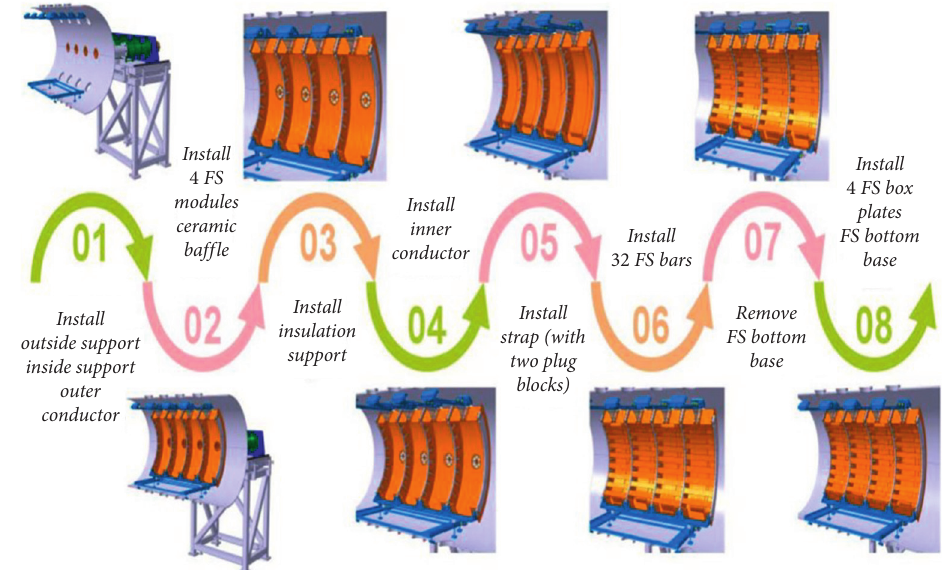
Figure 10: Assembly process of the HHFW antenna.